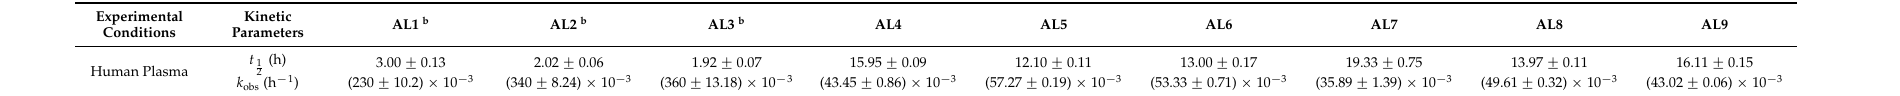
Table 2. Plasma stability studies of AL1 – 9 a